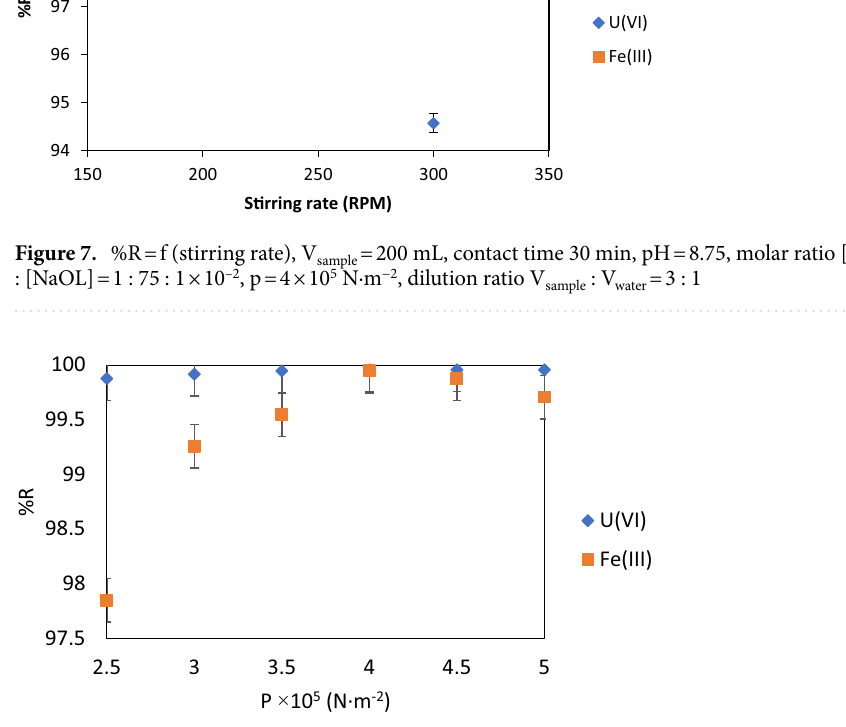
Figure 8. %R = f (p), V sample = 200 mL, stirring rate 250 RPM, contact time 30 min, pH = 8.75, molar ratio [U(VI)] : [Fe (III)] : [NaOL] = 1 : 75 : 1 × 10 –2 , p = 4 × 10 5 N·m −2 , dilution ratio V sample : V water = 3 :